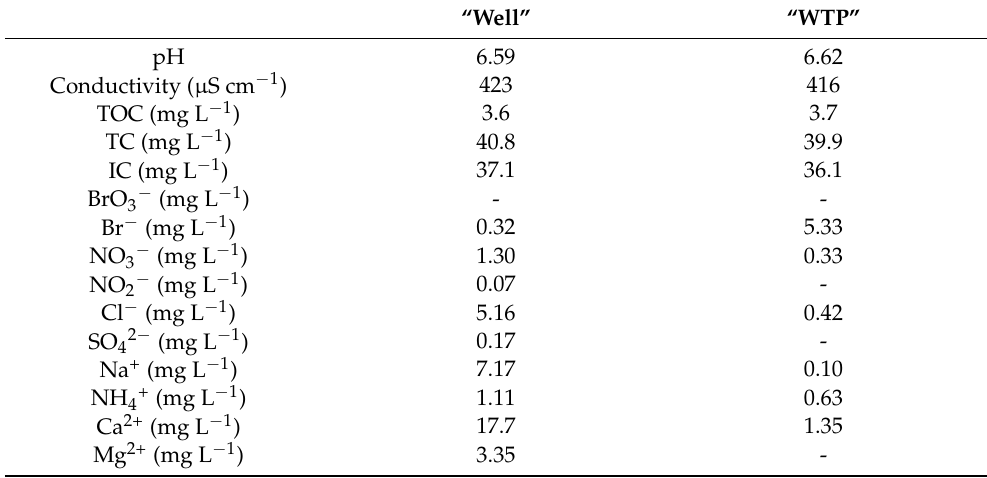
Table 1. Characteristics of groundwater obtained from a well and from a WTP in Coimbra, Portugal.